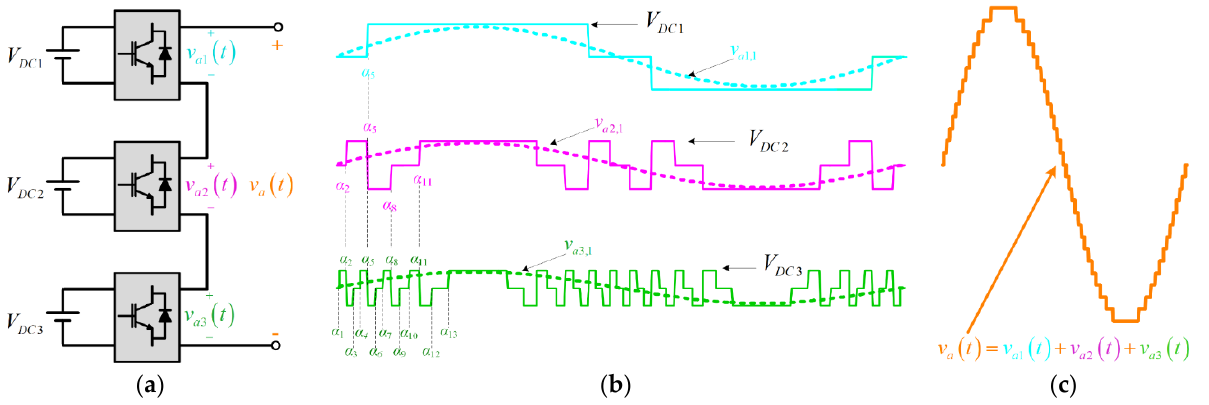
Figure 1. ( a ) Topology single-phase Cascaded H-Bridge for asymmetric inverters with 27 levels with regeneration, ( b ) individual output voltage for m =1.0, ( c ) output voltage for m = 1.0.